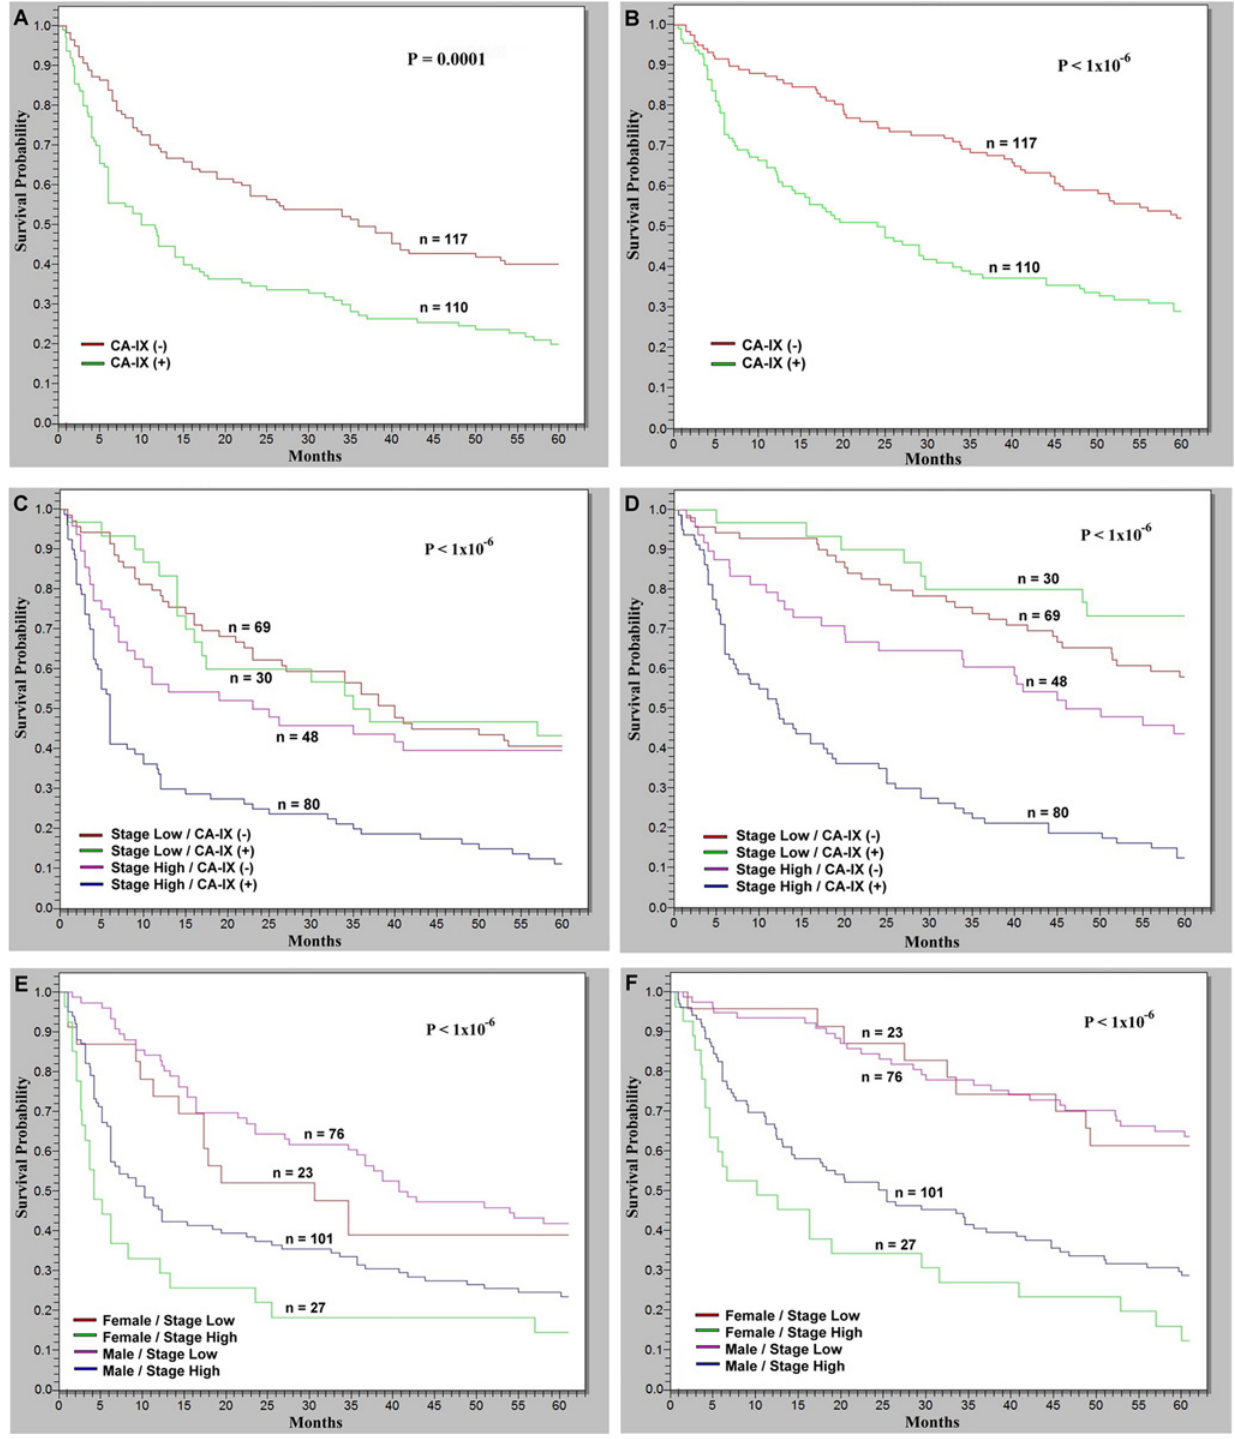
Fig 2. Kaplan – Meier analyses of 5-year disease free survival (DFS) and 5-year overall survival (OS) in 227 patients with HCC. (A and B) The HCCs with CA-IX protein expression correlated with significantly lower DFS and OS than the HCCs without CA-IX protein expression ( P = 0.0001 and P < 1x10 -6 , respectively). (C and D) The combinatorial analyses revealed that CA-IX-positive high-stage HCCs had the lowest DFS ( P < 1 x10 -6 ) and OF ( P < 1x10 -6 ), which were lower than CA-IX negative high-stage HCCs ( P = 0.0004 and P < 1x10 -6 , respectively). However, there were no differences concerning both DFS and OS in low-stage HCCs regardless presence or absence of CA-IX expression. (E and F) The female patients presenting with high-stage HCCs exhibited